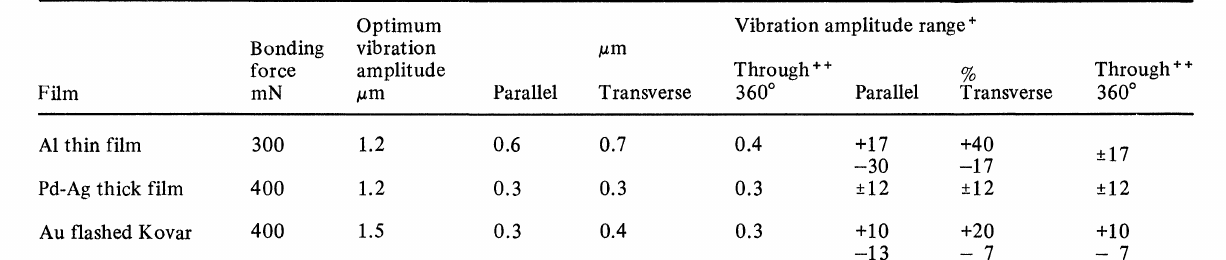
Figure 7, for a sample of 100 bonds made at the 1.2/am amplitude show strengths ranging between 40 and 100 mN for parallel vibrations and 50 to the majority of strengths fall in the 60 to 80 mN